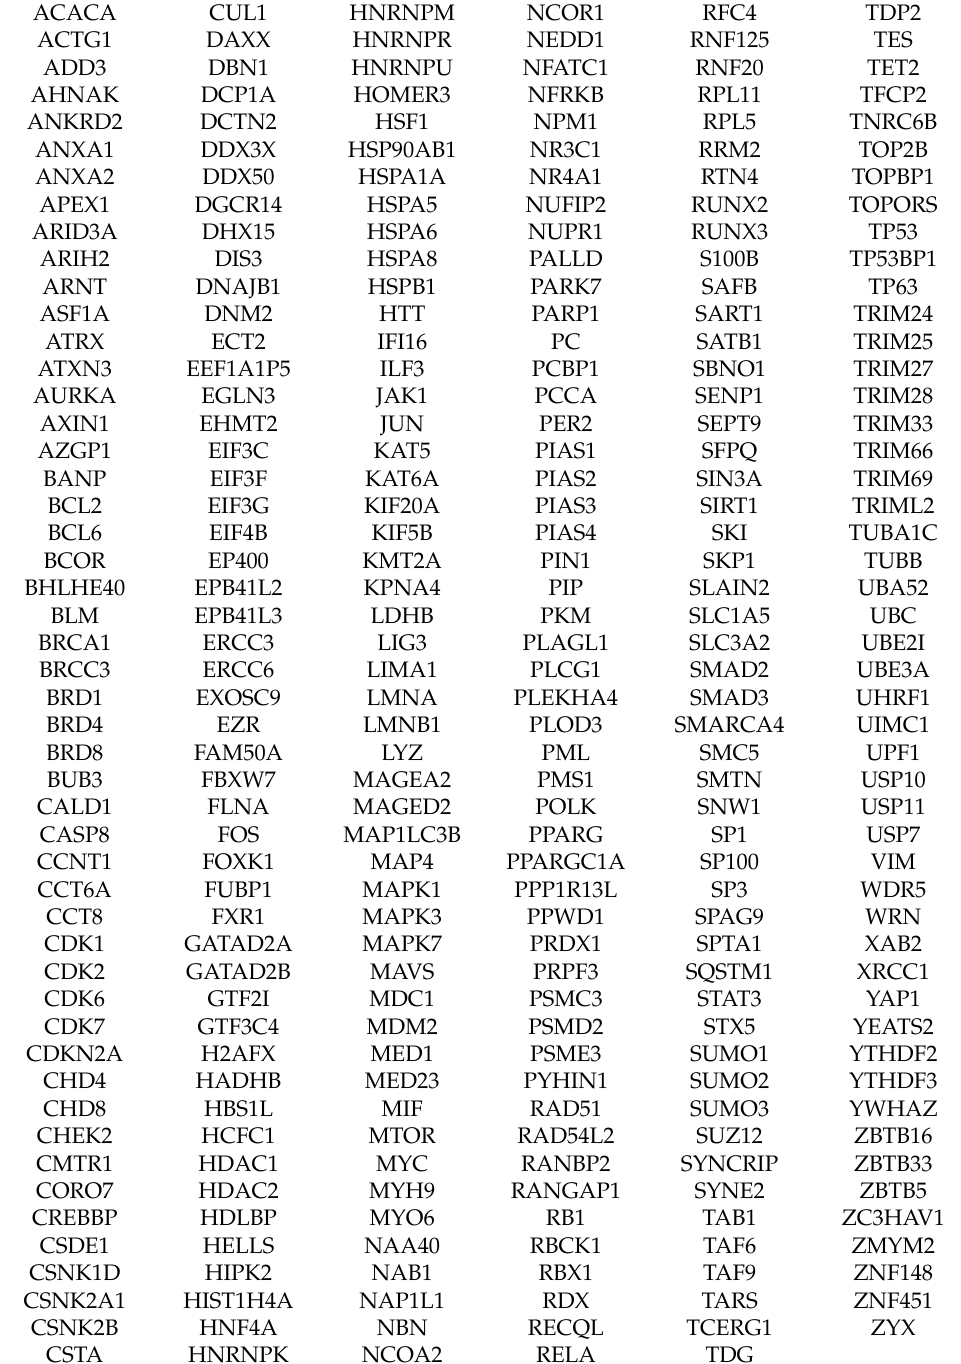
Table 1. List of 299 human proteins which interact with both p53 and PML. Proteins interacting with p53 or PML protein were retrieved from the BioGRID database (status: June 2022), and proteins associating with both p53 and PML were identified. Proteins are listed in alphabetical